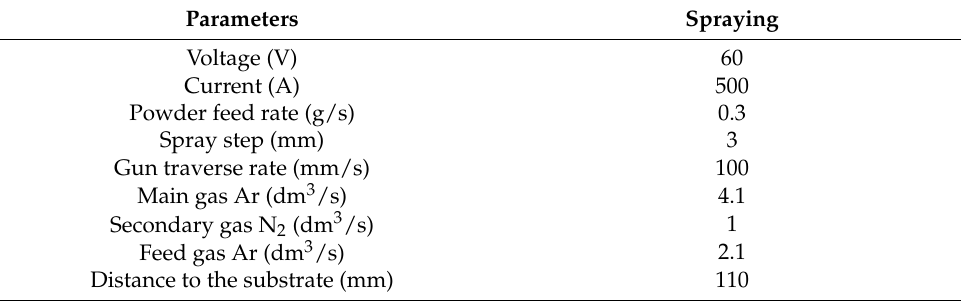
Figure 1. The SEM images of HA powder. Table 4. Plasma spraying parameters selected for depositing HA coating.